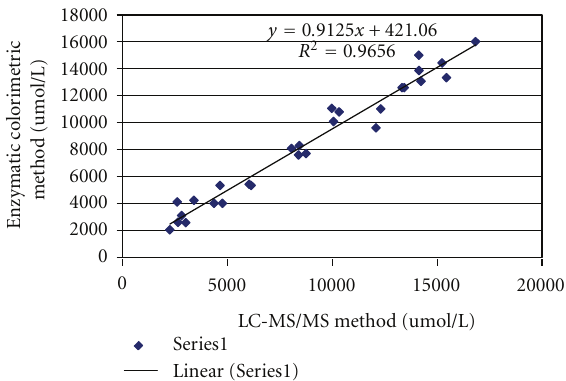
Figure 4: Comparison of human urine creatinine measured by LC- MS-MS and enzymatic colorimetric methods ( n = 28). Solid line